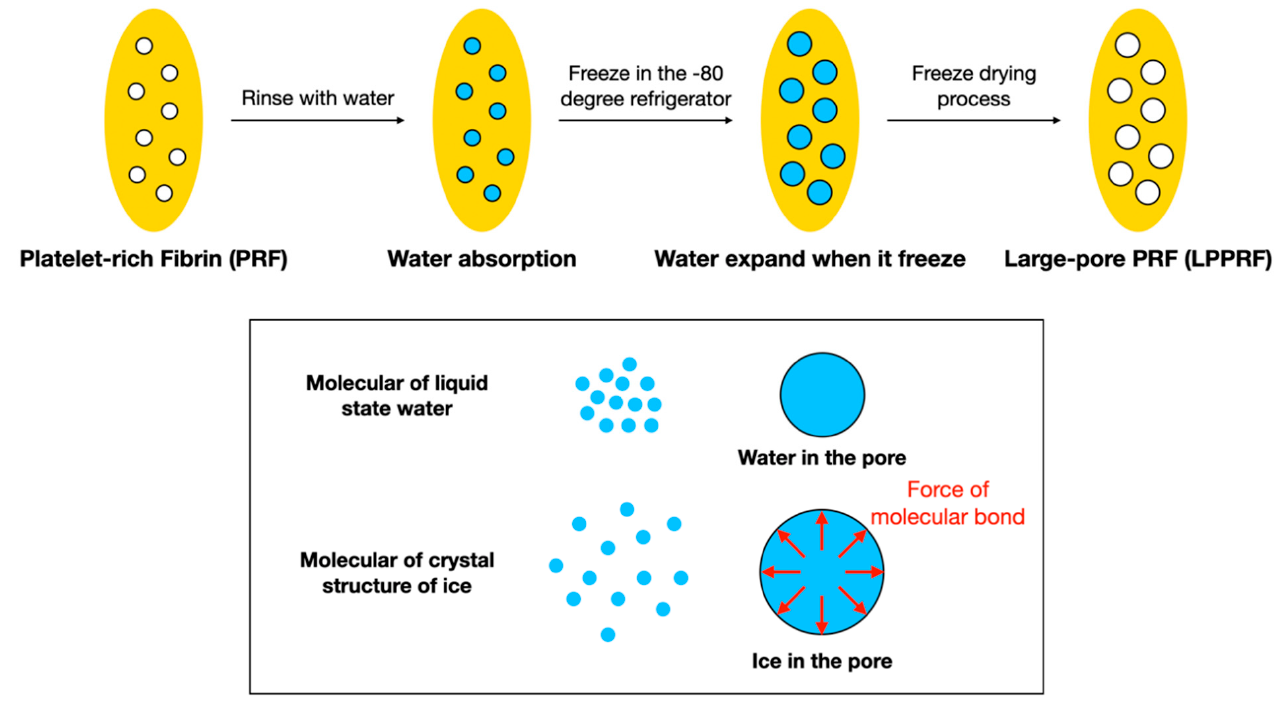
Figure 12. Large-pore platelet-rich fibrin preparation procedure and the molecular basis of why water expands when frozen.